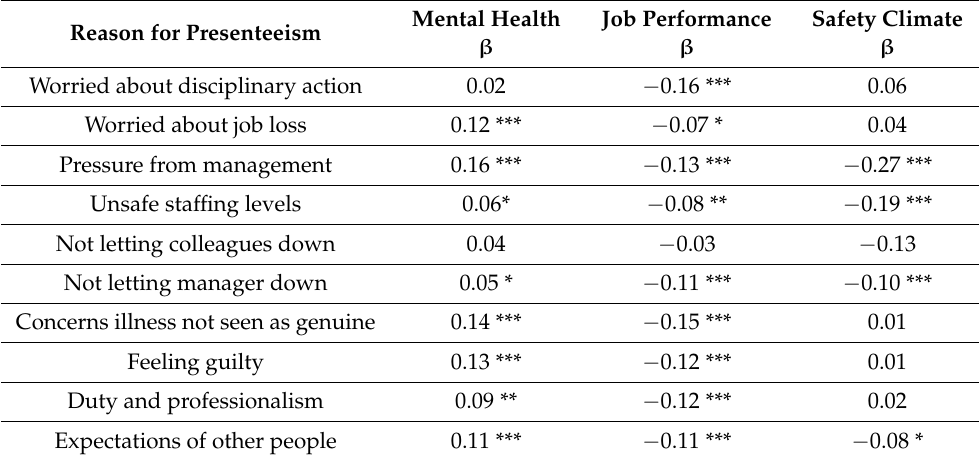
Table 3. Predictors of outcome variables: mental health, job performance and safety climate. Reason for